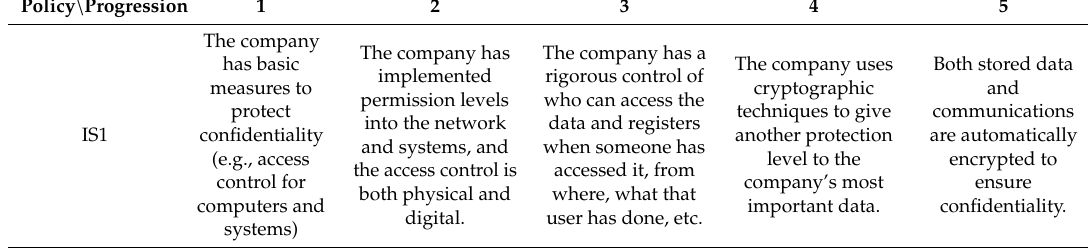
Table 22. Information security policies’ progression